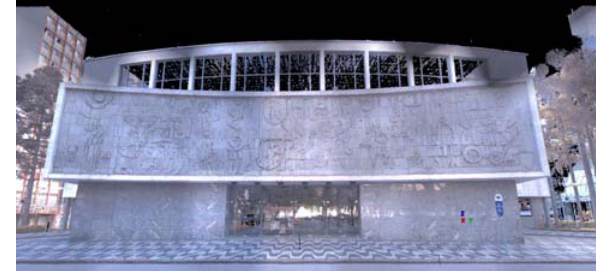
Figure 6. Point Clouds in perspective with Image Texture Map of the Front Elevation_Main Entrance with Poty Lazarotto’ concrete art